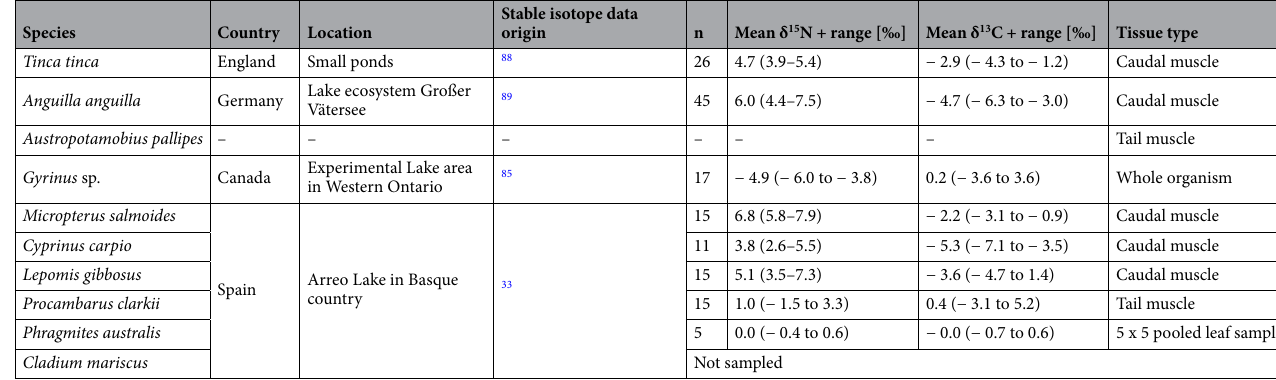
Table 4. Origin and ranges of finally considered stable isotope data after standardization by subtracting the communities’ respective